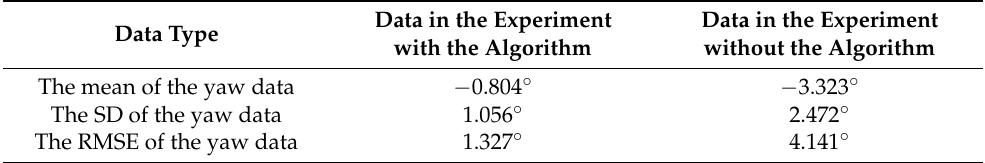
Table 3. Comparison of data in two experiments.